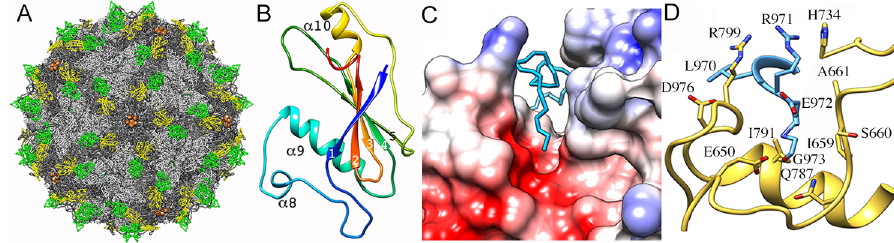
Fig 5. Putative enzyme activity on the RnQV1 outer capsid surface. (A) The P2 Asp227-Tyr350 domain (yellow)and P4 Val648-His805 domain (green)of a heterodimer are shown on the outer RnQV1 surface. P4 plugs at the five-fold axes are shown (orange).(B) The P2 Asp227-Tyr350 domain,rainbow-colored, with the topology found on the capsid surface. The five anti-parallel β -strands are indicated(1–5), as are the three helices( α 8, α 9, α 10). (C) The P4 surface cleft (shown with electrostatic potentials) in which the P2 C terminus is located(blue, sticks). (D) Close-upof the P2 C-terminal segment (blue) in the P4 surface cavity (yellow), orientedas in c. Residuesare displayedas sticks.